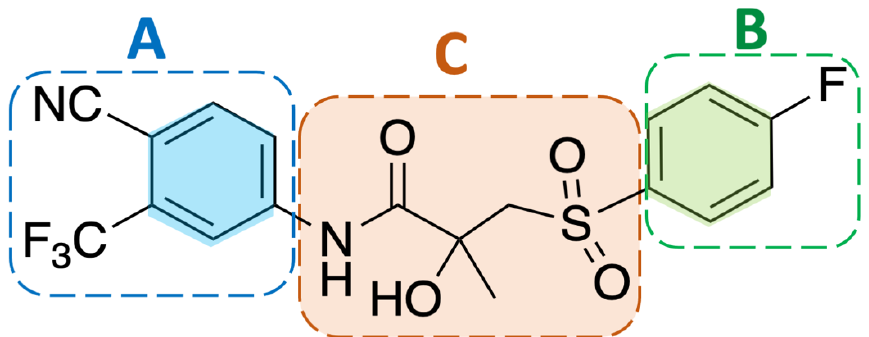
Figure 2. Chemical structure of bicalutamide and the areas of structural modifications, ring A , ring B , and the linker area C .